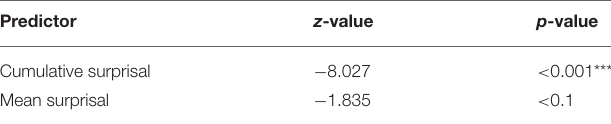
TABLE 10 | Most influential effects in the final GLM predicting position, after removing interactions, 1850–1900.